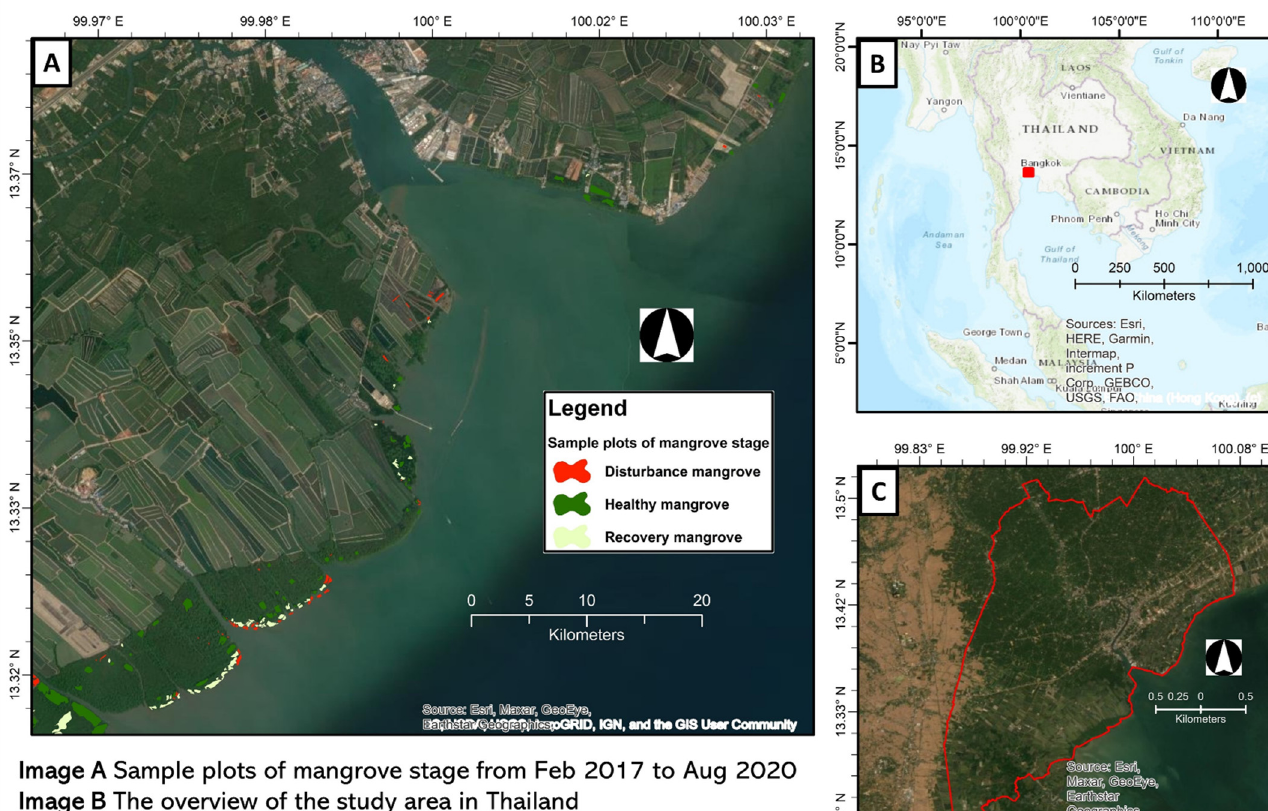
Figure 1. Study Area